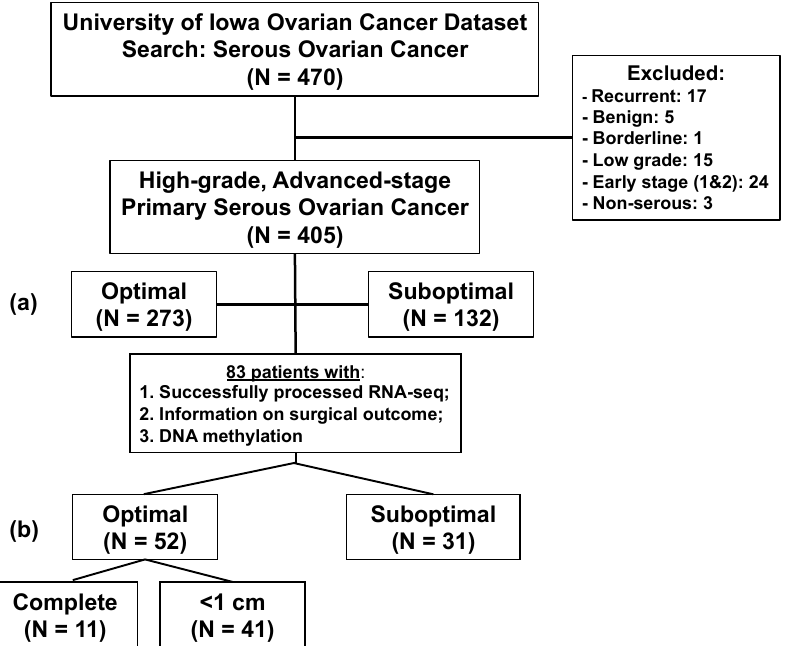
Figure 1. The flow of included patients in the analysis. Of the initial 470 HGSC patients, 405 were confirmed to be high-grade, advanced stage, of serous histology: ( a ) 273 underwent optimal PCS, and 132 underwent suboptimal PCS. A total of 187 had frozen tumors in the biobank, and RNA-seq and DNA methylation was successful in 83: ( b ) 31 underwent suboptimal PCS and 51 underwent optimal PCS, 11 of them (or 22%) with R0 or no macroscopic disease.